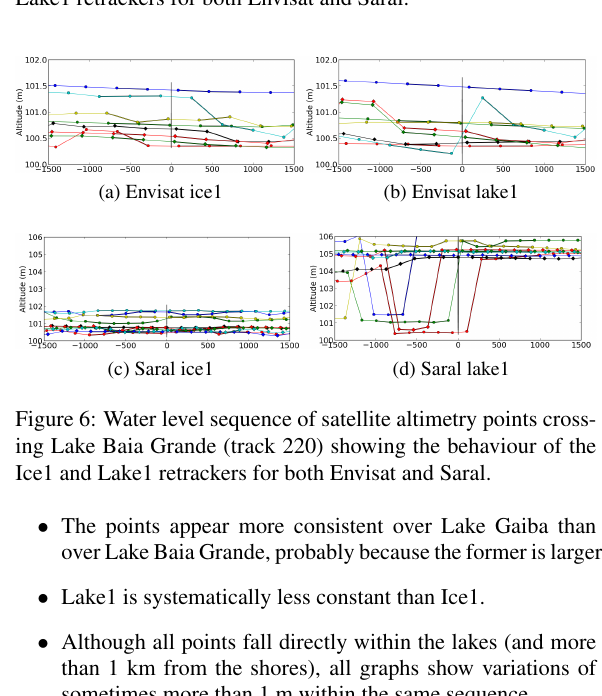
Figure 5: Water level sequence of satellite altimetry points cross- ing Lake Gaiba (track 220) showing the behaviour of the Ice1 and Lake1 retrackers for both Envisat and Saral.